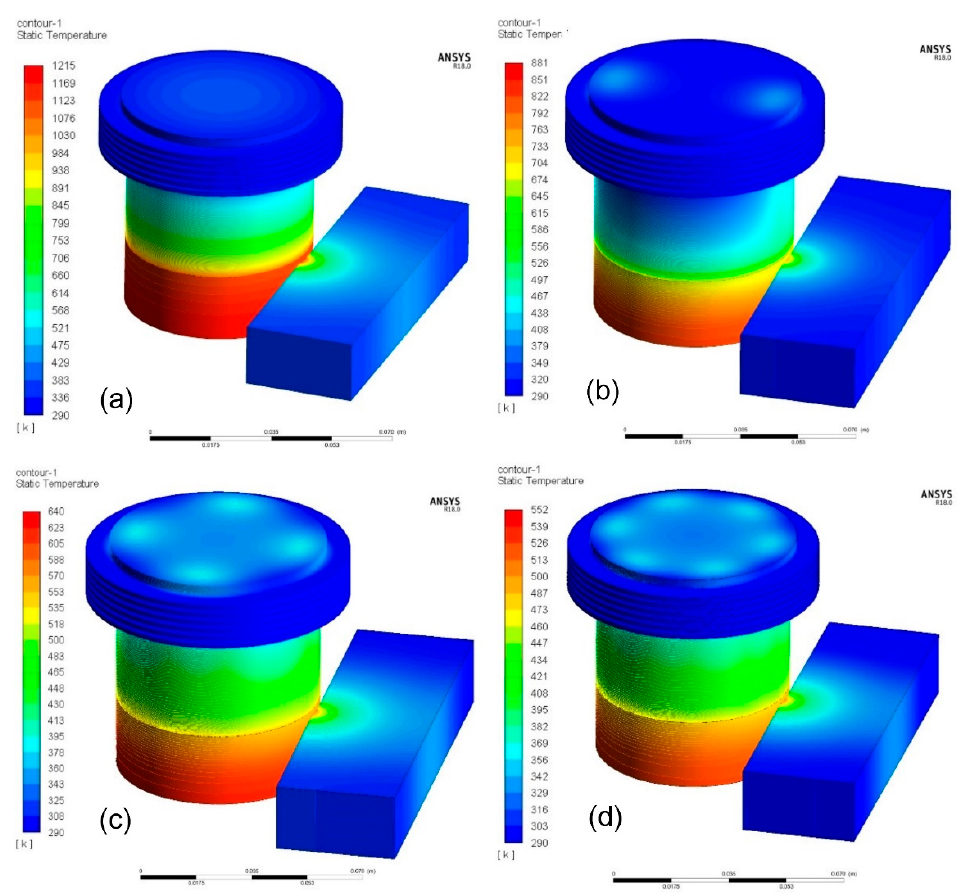
Figure 8. Temperature distribution under a grinding heat flux of 10 7 W/m 2 : ( a ) non-OHP, ( b ) 2 OHPs, ( c ) 4 OHPs and ( d ) 6 OHPs (Temperature unit: K).